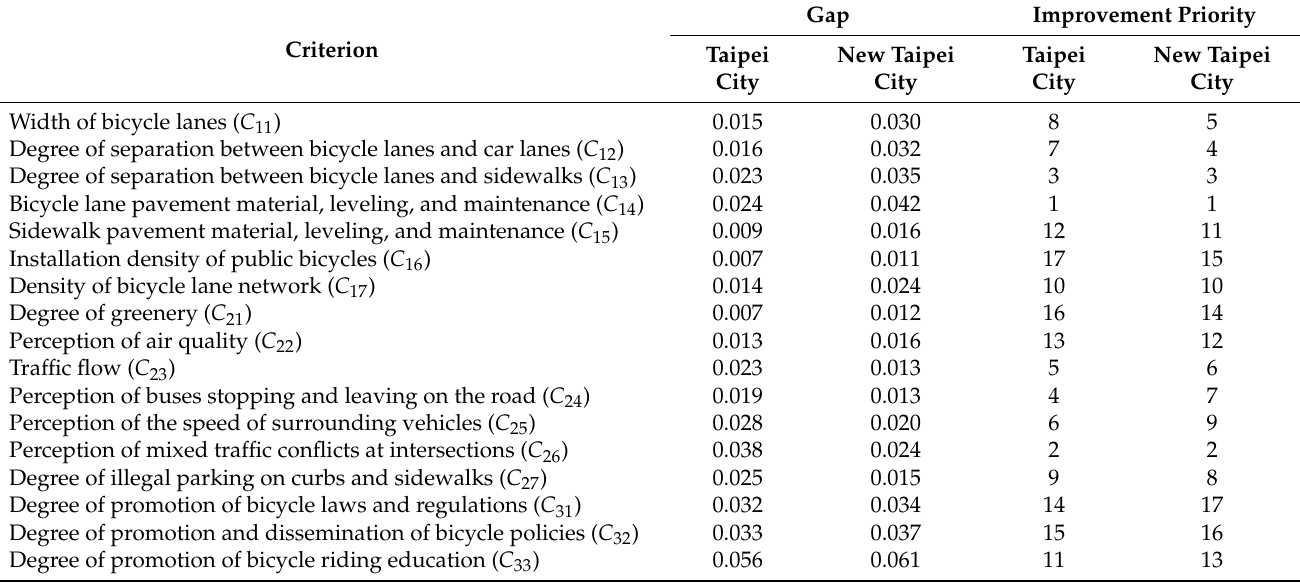
Table 8. Improving priorities of bikeability in two